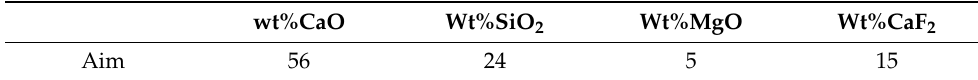
Table 2. Aimed slag composition for laboratory